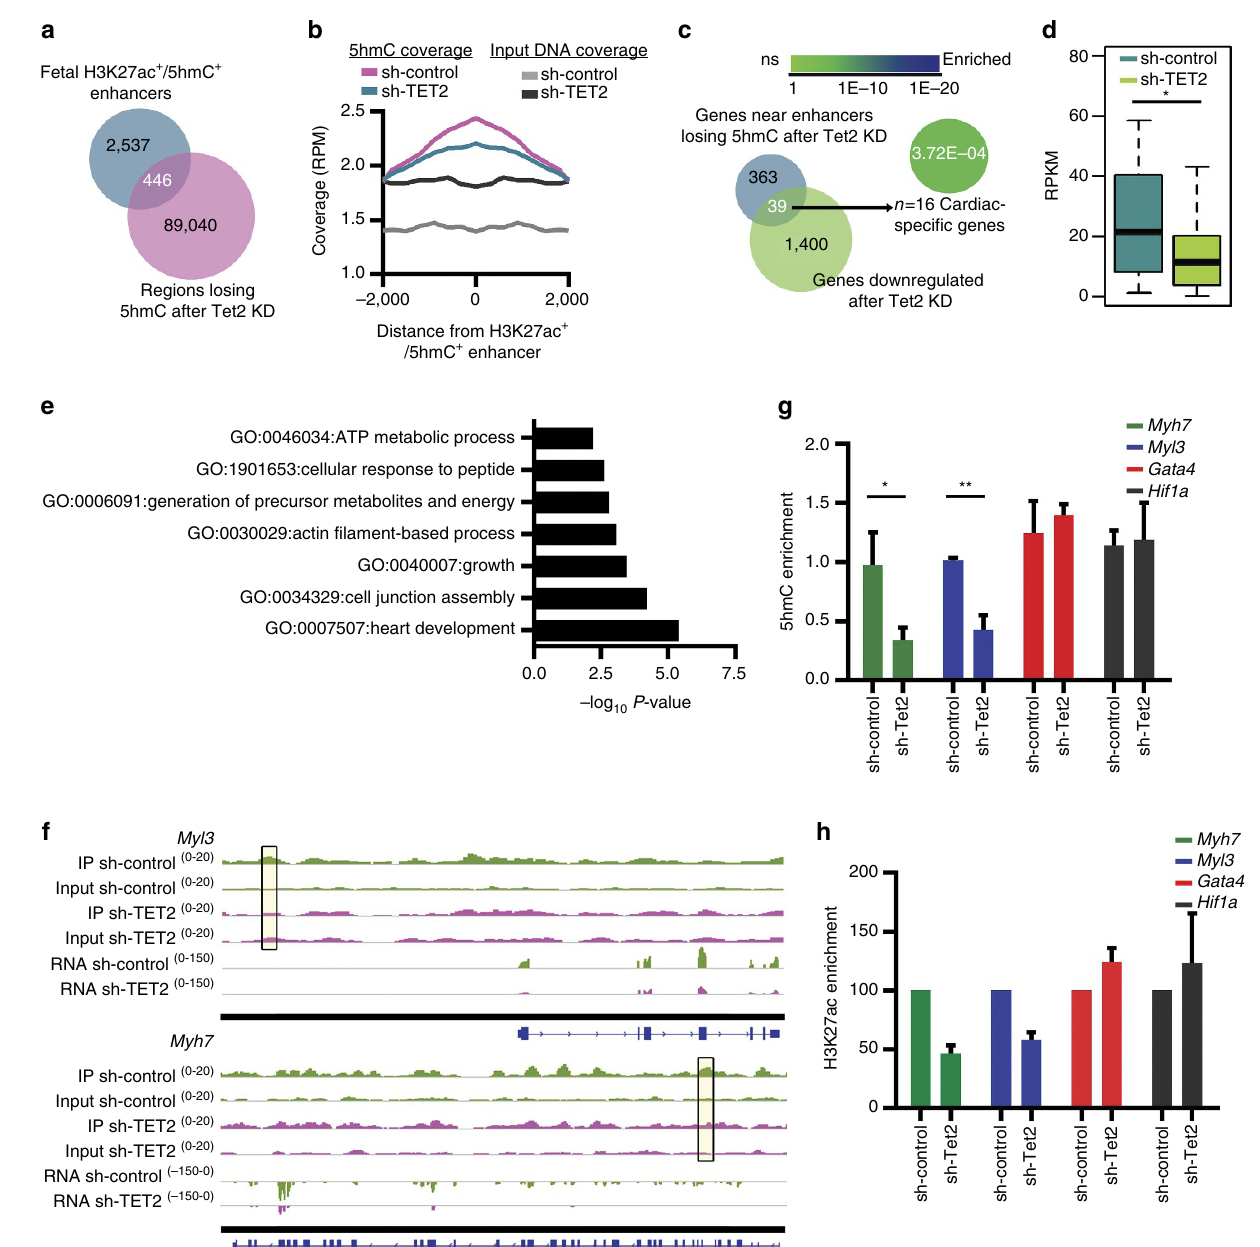
Figure 7 | 5-hmC-enriched enhancers affected by KD of TET2 enzyme. ( a ) Venn diagram showing the overlap in the number of H3K27ac þ /5-hmC þ enhancers identified in fetal stages (E14.5 and neonatal CMC s) and the number of regions undergoing loss of 5-hmC after Tet2 KD, identified by MeDIPS. ( b ) Average coverage profile of 5-hmC and input DNA coverage across the H3K27ac þ /5-hmC þ enhancers undergoing loss of 5-hmC after Tet2 KD. Distance from enhancer (bp) is given on the x axis. RPM, read counts per million mapped reads. ( c ) Venn diagram showing the overlap in the number of genes ( n ¼ 402) proximal to the 446 H3K27ac þ /5-hmC þ enhancers undergoing loss of 5-hmC and the number of genes downregulated (RNA-seq) after Tet2 KD. Enrichment of genes within the MGI cardiovascular expression database, calculated with Fisher’s exact test. ( d ) RNA-seq expression values in sh- Tet2 and sh-control CMCs for the single nearest gene associated with an H3K27ac þ /5-hmC þ enhancer depleted of 5-hmC after Tet2 RNA KD. Boxplots give the median (bold line), with whiskers extending to ± 1.5 of the interquartile range. * P -value r 0.01 (Mann–Whitney test). ( e ) Enriched GO terms relative to the 39 genes in d . GO analysis was performed with Metascape 1.0 ( P -value r 0.01). ( f ) IGV profile of 5-hmC MeDIP-seq and RNA-seq in sh- control and sh-Tet2 CMCs showing one intergenic (top) and one intragenic (bottom) H3K27ac þ /5-hmC þ enhancer region depleted of 5-hmC (boxes) after Tet2 RNA KD, respectively, proximal to Myl3 and Myh7 . Scale for each track is shown on the left. ( g ) qPCR analysis of 5-hmC enrichment on Myl3 , Myh7 , Gata4 and Hif1a H3K27ac þ /5-hmC þ enhancers. Data are presented as mean ± s.d. ( n ¼ 3). * P -value r 0.05; ** P -value r 0.01 (unpaired Student’s t -test). ( h ) ChIP analysis of the enrichment of H3K27ac on Myl3 , Myh7 , Gata4 and Hif1a H3K27ac þ /5-hmC þ enhancers. Data are presented as mean ± s.d. ( n ¼